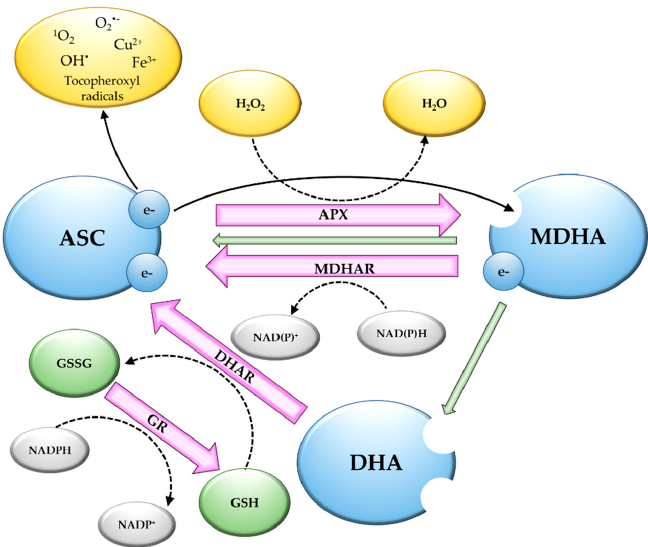
Figure 1. Redox-dependent reactions of vitamin C. ASC can donate electrons directly to reactive oxygen species, metals, and tocopheroxyl radicals. The reduction of H 2 O 2 by ASC occurs via APX. MDHA can undergo dismutation (green arrows), providing ASC and DHA. The reduction of oxidized forms occurs through the ASC - GSH cycle. MDHA and DHA are reduced by MDHAR and DHAR, respectively, whereas the reduced glutathione is recovered by GR (more details are provided in the text). Abbreviations: ASC, ascorbate; APX, ascorbate peroxidase; DHA, dehydroascorbate; DHAR, dehydroascorbate reductase; MDHA, monodehydroascorbate; MDHAR, monodehydroascorbate reductase; GR, glutathione reductase; GSH, glutathione; GSSG, glutathione